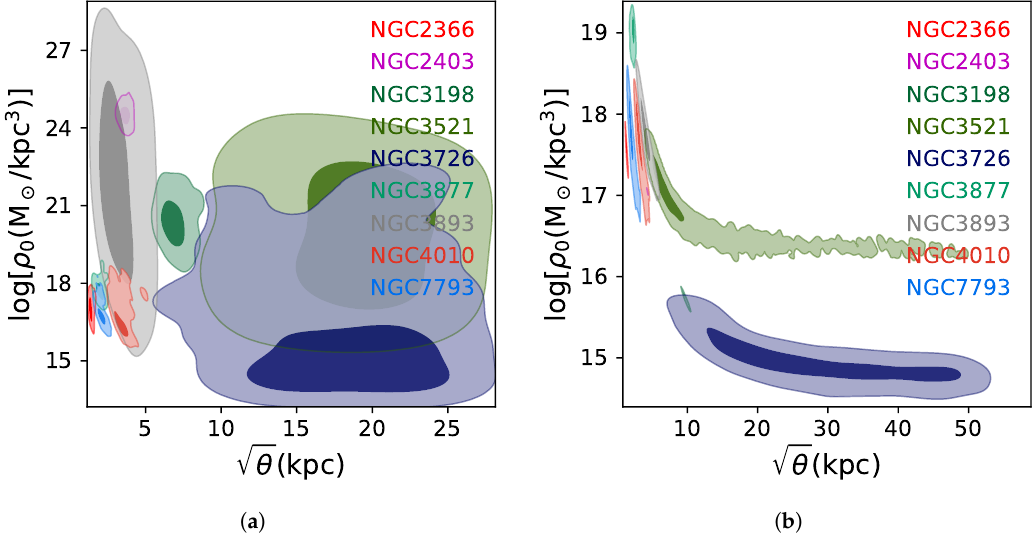
√ θ or r − 2 /2) for: Einasto ( a ) and NC-like ( b ). Darker region represent